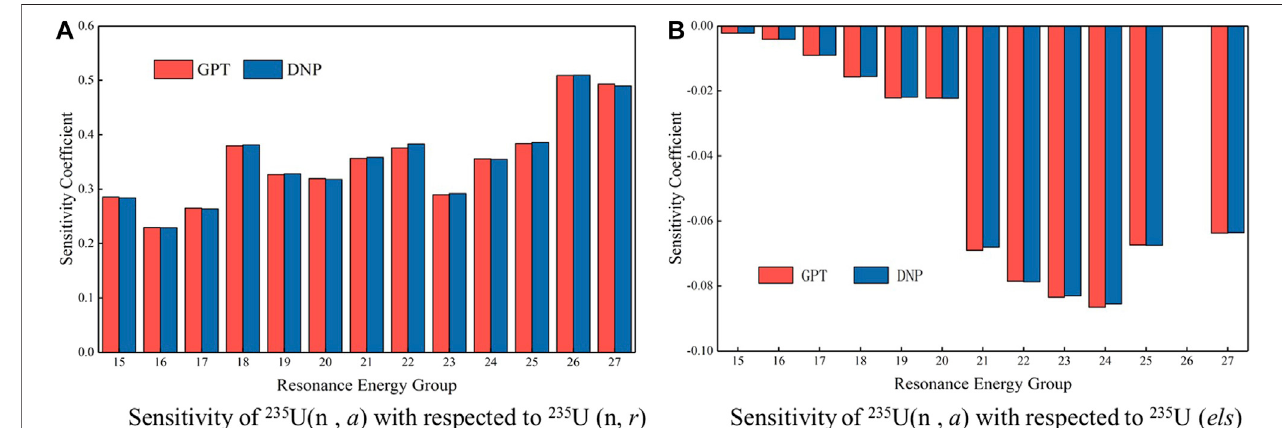
FIGURE 6 | Comparisons of implicit sensitivity coef fi cients for resonance nuclides.